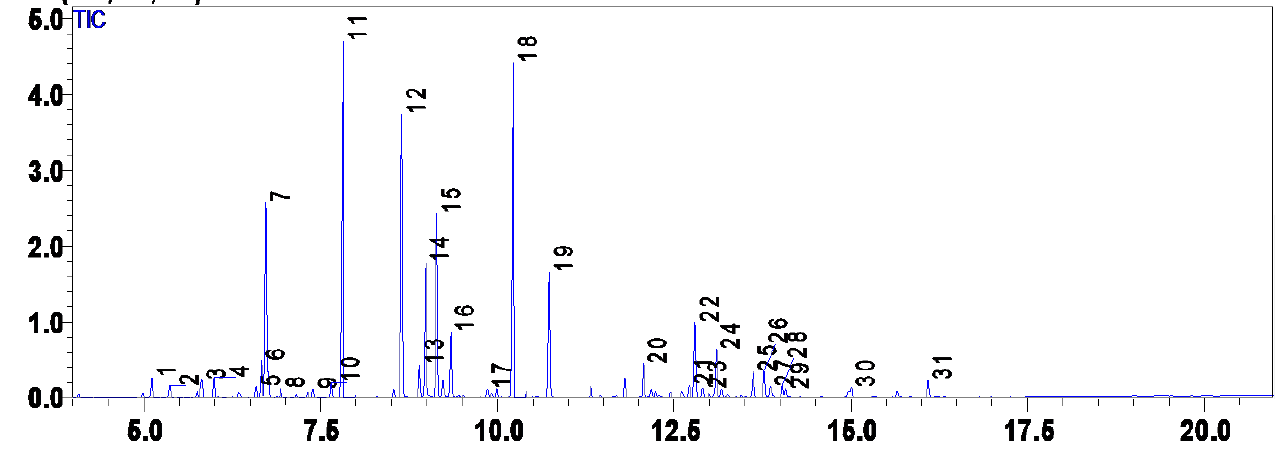
Figure 5. Gas Chromatography chromatogram of the essential oil of L. officinalis of Jerada (Morocco).